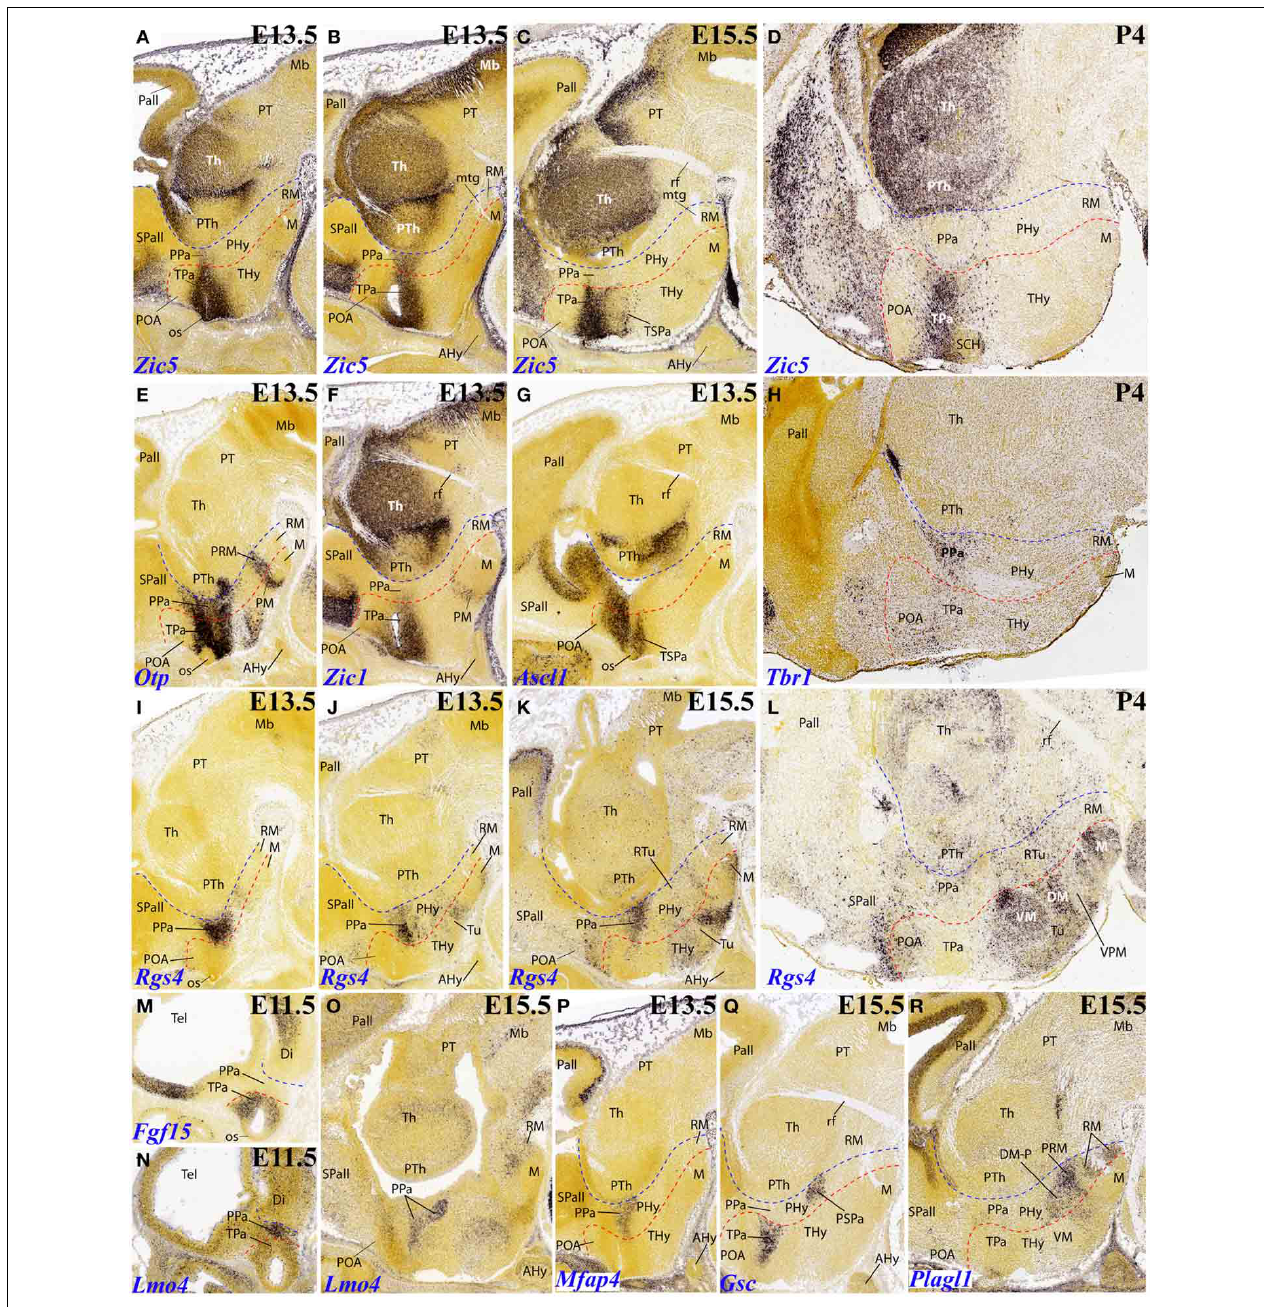
(G), Tbr1 (H), Rgs4 (I–L), Fgf15 (M), Lmo4 (N,O), Mfap4 (P), Gsc (Q) and Plagl1 (R). All images were downloaded from the Allen Developing Mouse Brain Atlas (http://developingmouse.brain-map.org/). For abbreviations, see the list. Red dotted line: THy/PHy boundary. Blue dotted line: PHy/p3